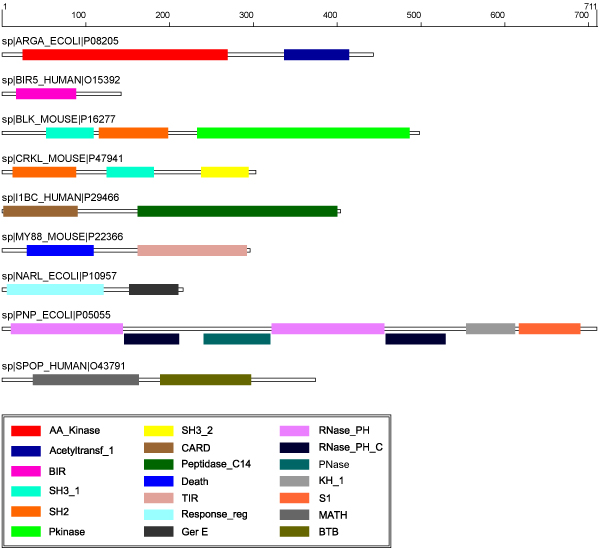
PFAM domain architecture of the seed dataset used to evaluate BLAST, PSI-BLAST, T2K and FlowerPower. Sequences were selected based on the following criteria: each sequence had to contain recognizable PFAM domains (based on the PFAM gathering threshold), no undefined regions of >80 amino acids (i.e., a region with no PFAM match), and each PFAM domain was required to match a 3D structure classified by the SCOP database. For details of the seed sequence domain architectures see Table 1.